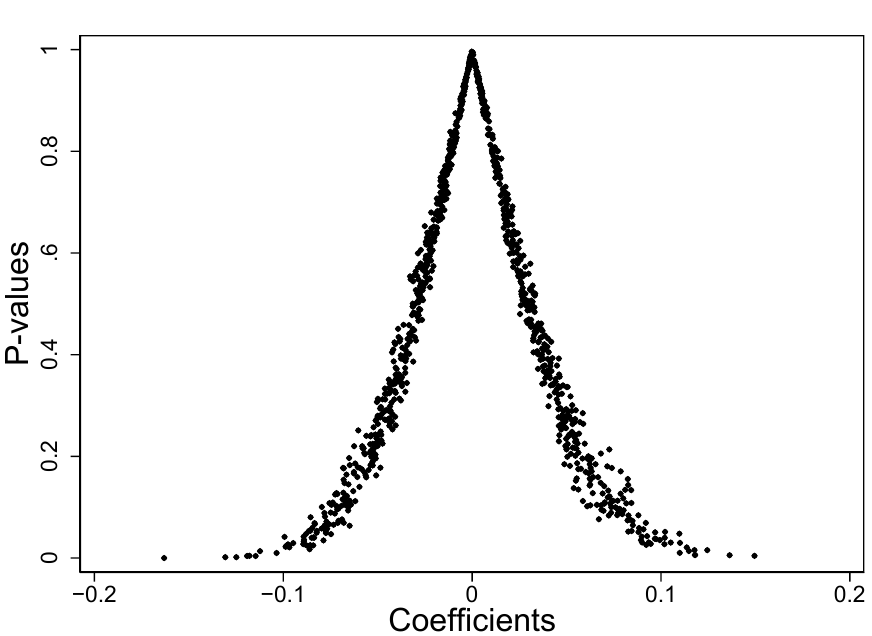
Figure 3. Scatter plot of { p-value } versus { β random }.